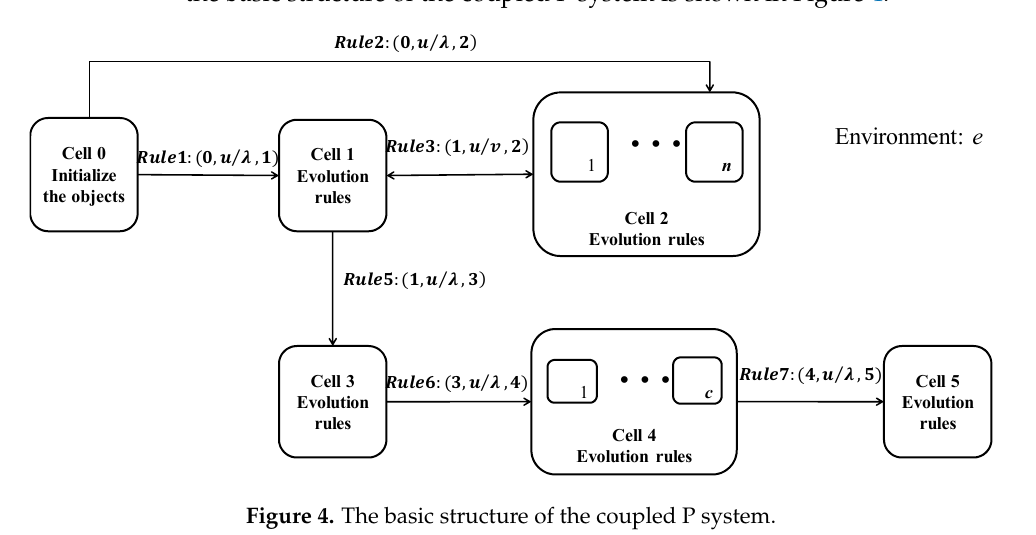
Figure 3 The flow chart of the proposed NCNNSC-CP algorithm.